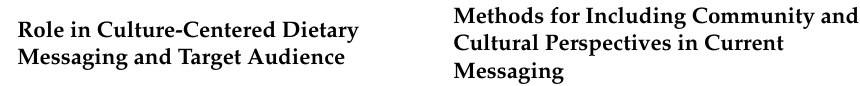
Table 3. Role of territorial (NWT), regional (ISR), and local (Tuktoyaktuk) stakeholders in the development and/or dissemination of dietary messages that incorporate community and cultural perspectives about food in/for the ISR, and approaches